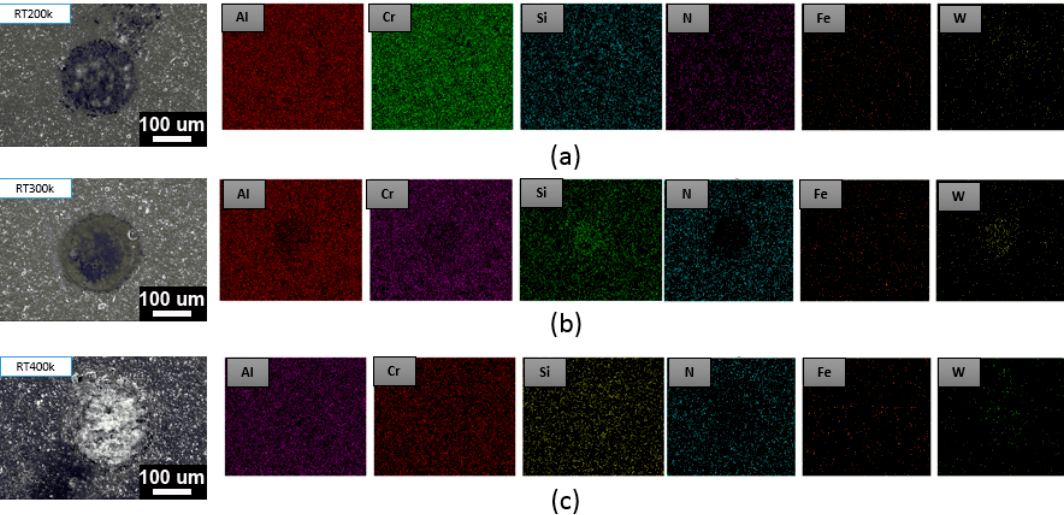
Figure 7. SEM and EDS element mapping of PN + AlCrSiN at room temperature after ( a ) 200k, ( b ) 300k, and ( c ) 400k impacts.